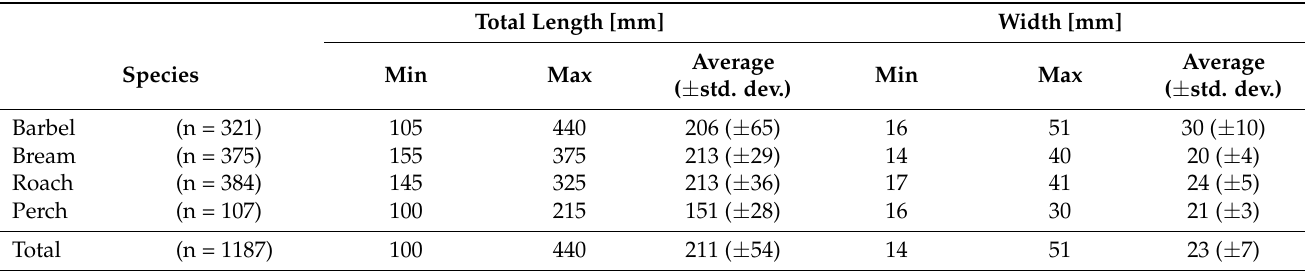
Table 1. Number, length and width of stocked fish in trials, minimum, maximum and average with standard deviations (std. dev.) [mm] used for during all conducted